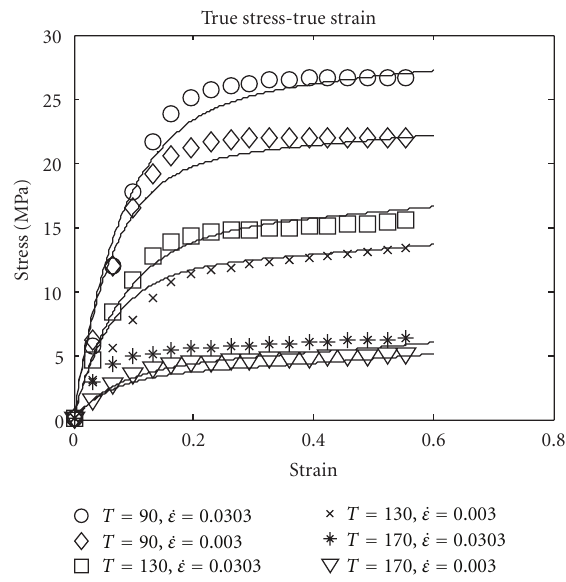
Figure 6: Comparison of numerical stress of thermocompression tests with experimental data.